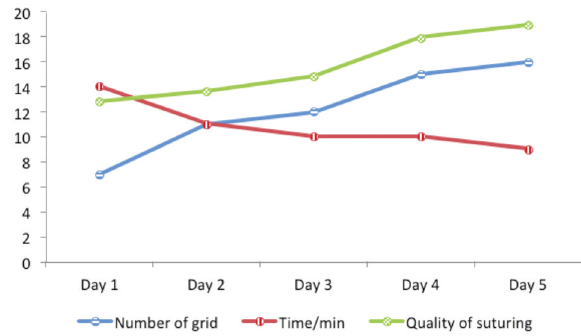
Global Rating Scale (GRS) to assess quality of suturing. Fig. 3: